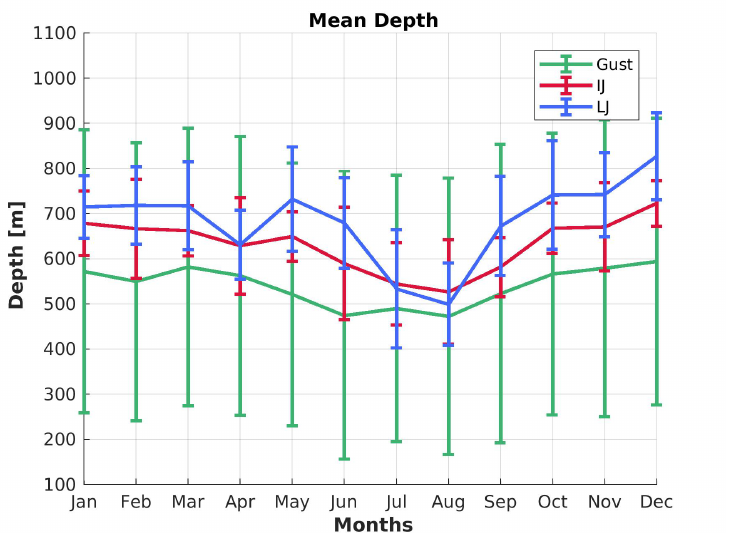
Figure 11. The mean depths of gusts, IJ and LJ are displayed with their standard deviations for every